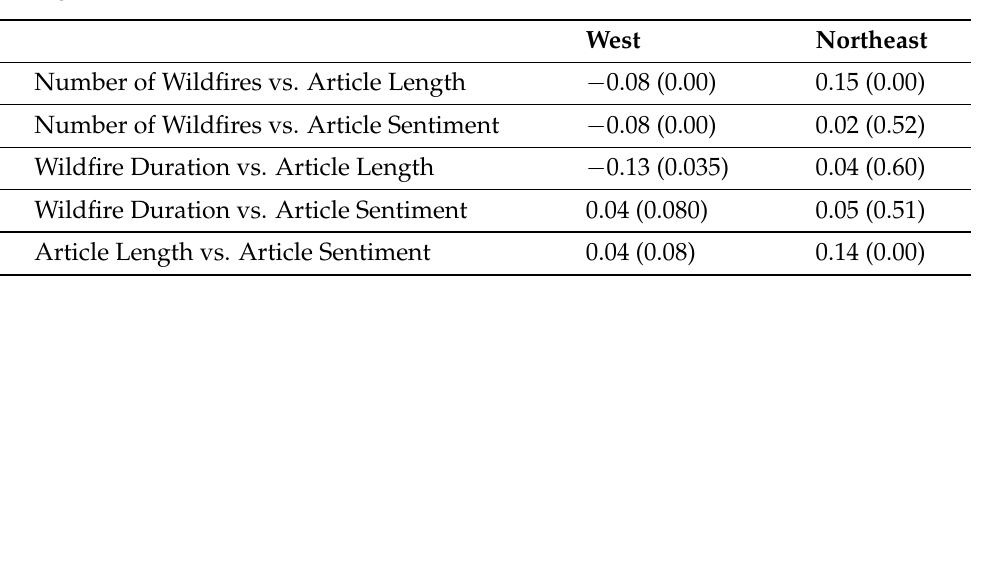
Table 2. Correlations between Wildfire Events and Coverage at a Daily Scale. Analysis conducted for 28000 (west) and 13000 (NE) records from 2014 to 2017. Values represent Kendall correlation-values: τ , with p -values in parentheses. Newspapers in the west trend towards less coverage and negative sentiment than the northeast newspapers. Correlations with fire size were not conducted due to missing